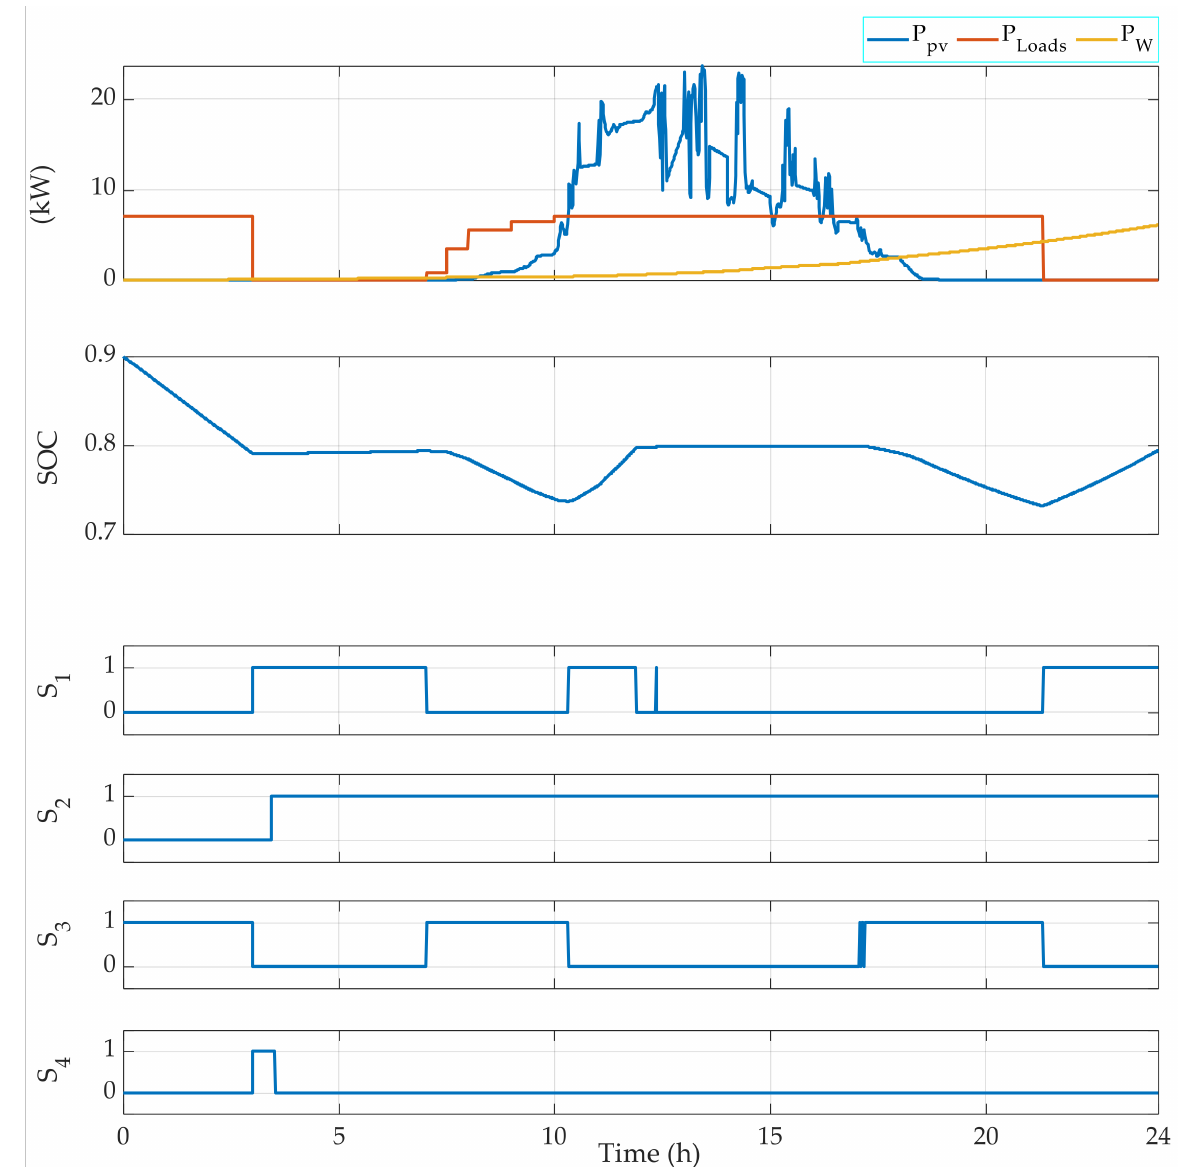
Figure 7. EMS results for the photovoltaic system in March using a variable loads power using an initially fully charged battery